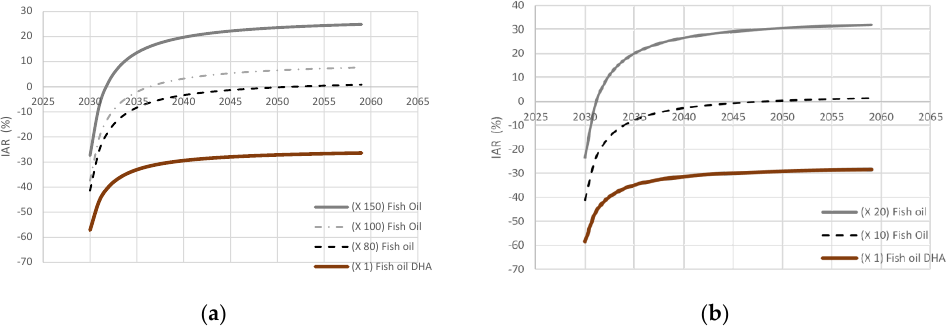
Figure 15. IAR economic indicator as a function of fish oil DHA reference cost, ( a ) 0.14 g/L/h and 27% oil content, ( b ) optimized C. cohnii 0.4 g/L/h and 70% oil content.